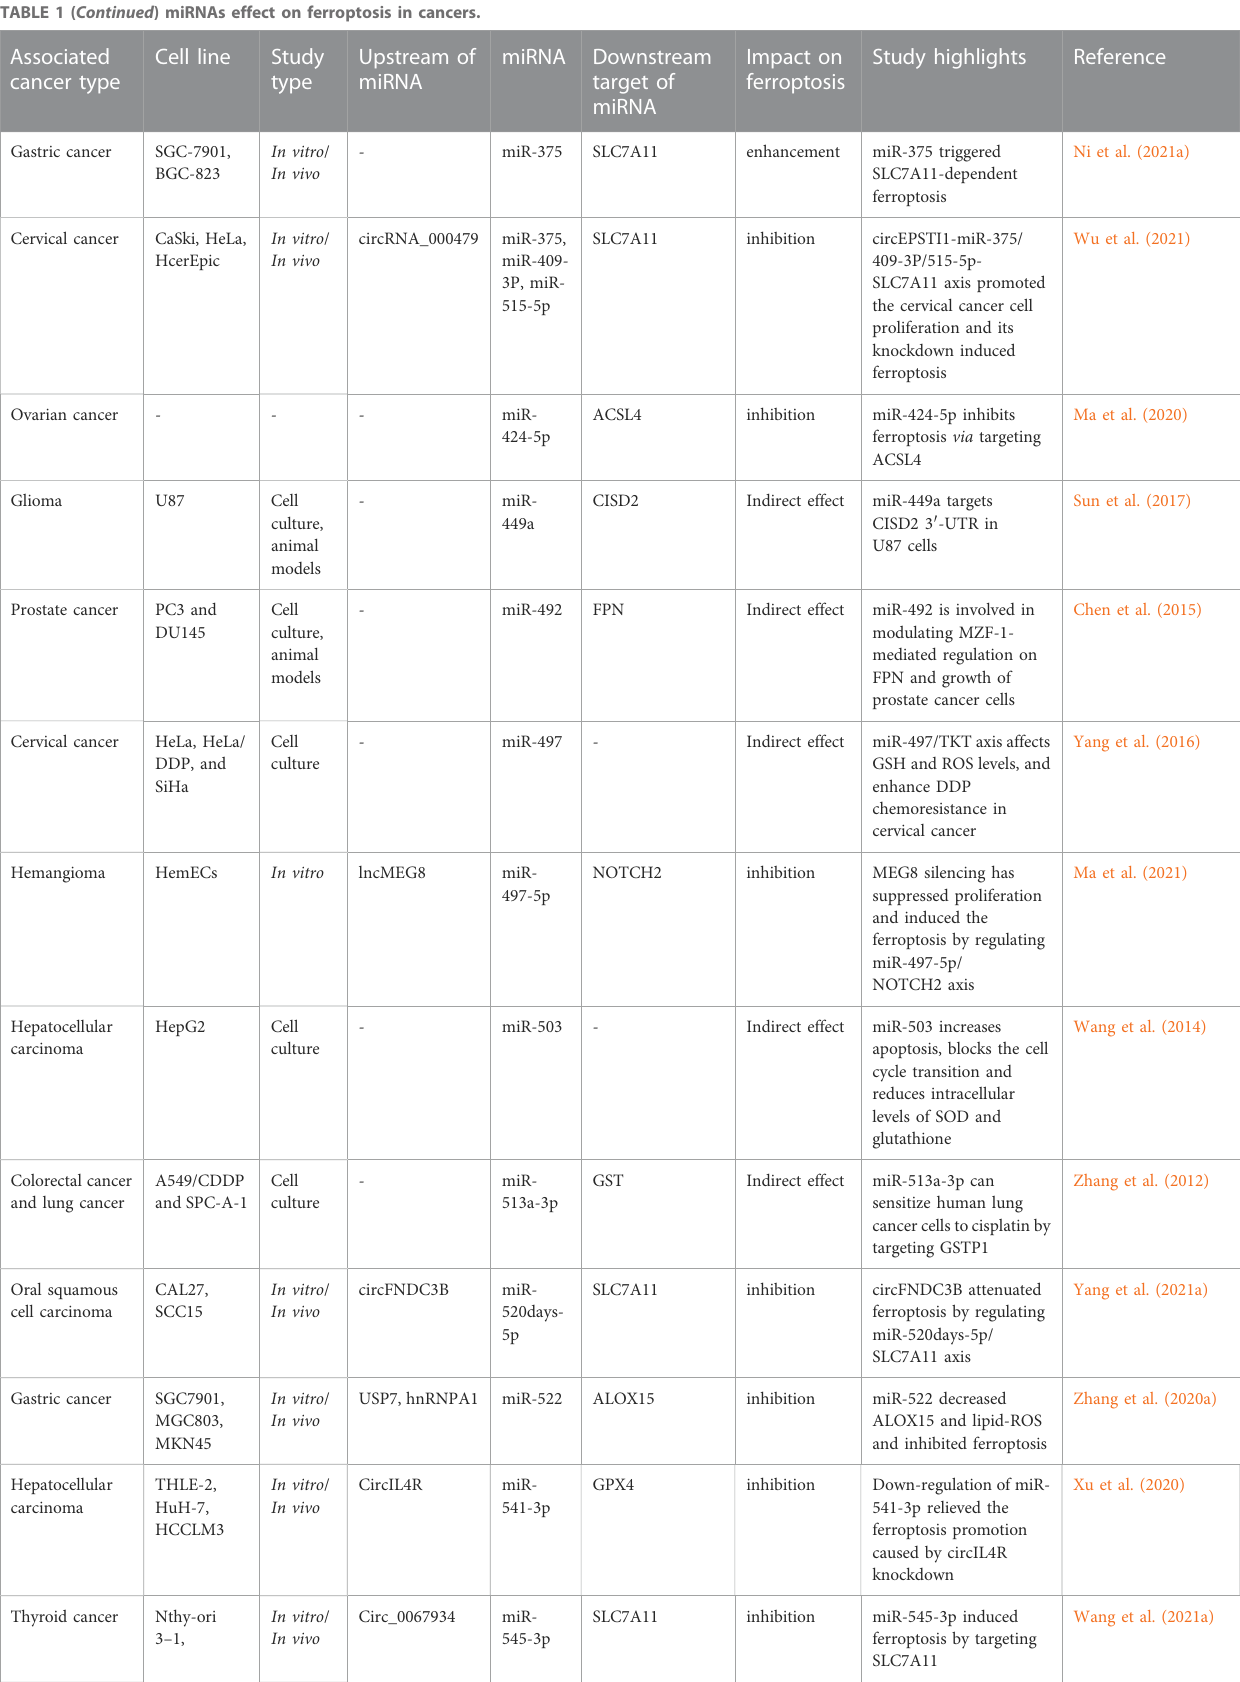
TABLE 1 ( Continued ) miRNAs effect on ferroptosis in